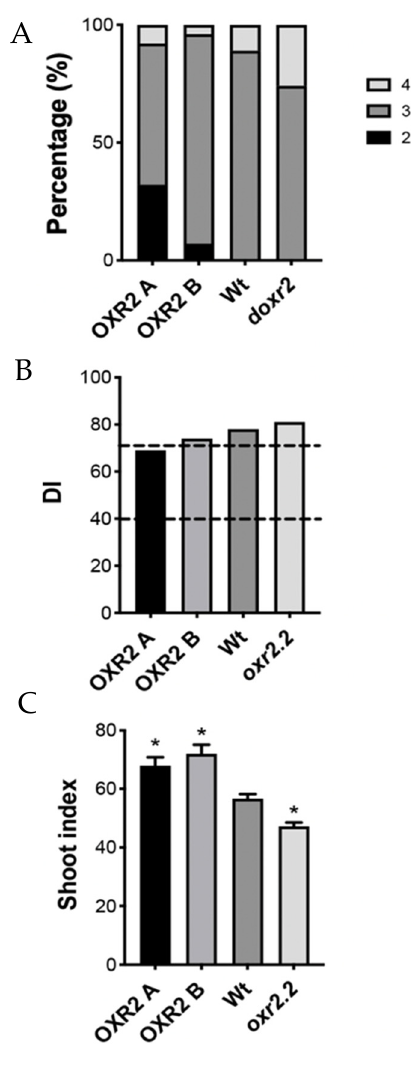
Figure 3. Inoculation of Col-0, oxr2, and two independent OXR2-OE ( OXR2 A , OXR2 B ) plants with 10 6 spores mL − 1 of P. brassicae . The controls were inoculated only with the buffer that had been used to resuspend the resting spores of the pathogen (see methods). In each experiment, one tray with 30 plants per condition in total was investigated. The data were evaluated 28 dai as a measure for disease severity. ( A ) The disease index (DI) ( B ), the percentage of plants in individual disease classes, and ( C ) the shoot index (shoot dry weight of infected vs. control plants) are given. Disease class 2 = small galls, class 3 = large galls, but the roots are still present, 4 = large galls, no roots are present. Results are expressed as mean ± SD ( n = 20). Asterisks indicate significant differences between genotypes at p < 0.01 (*) (ANOVA, LSD Fisher test).